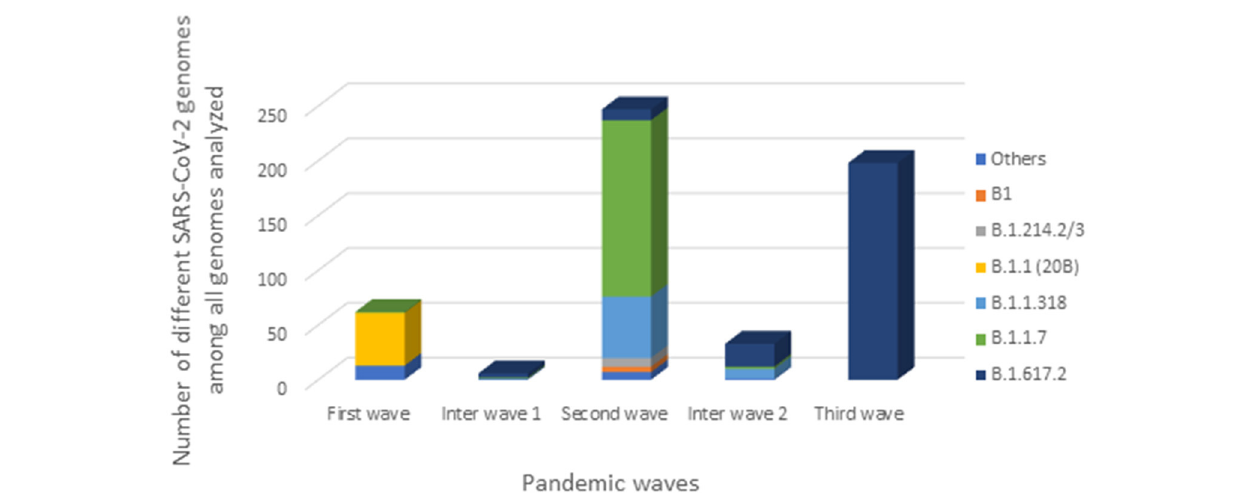
FIGURE 5 | Distribution of SARS-CoV-2 strains during the three Gabonese pandemic waves. “Others” represented the others genomes we found: lineage A, B.1.356, B.1.128, B.1.1.409, B.1.1.121, B.1.1.275, L.3, B.1.620, B.1.525.